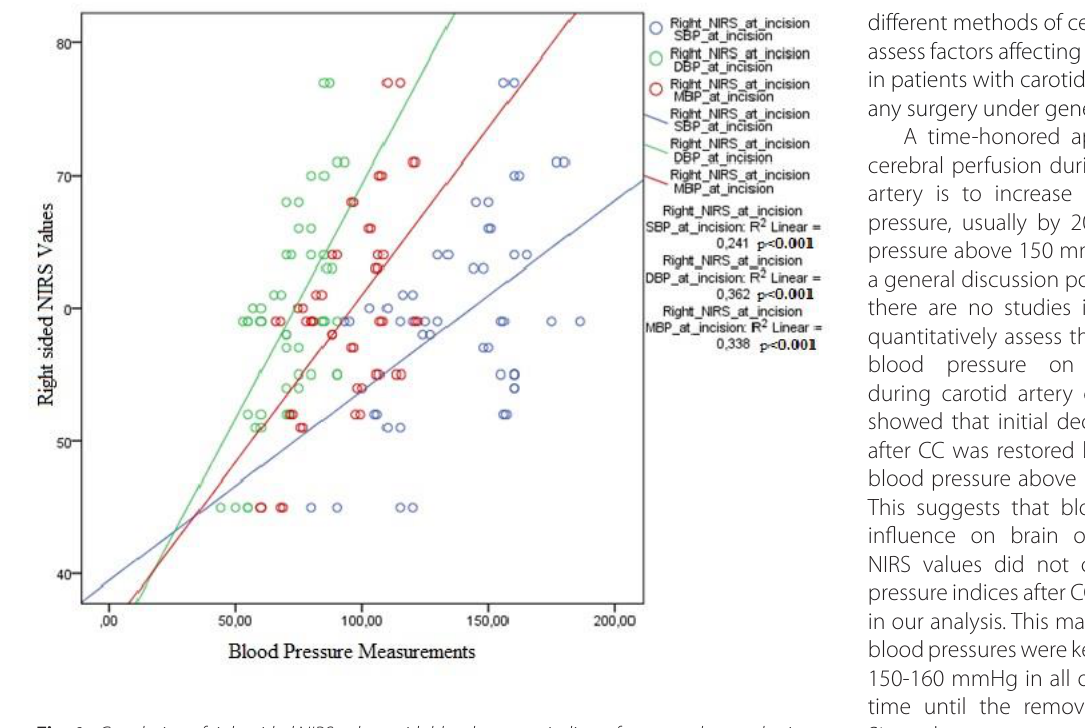
Fig. 1 - Correlation of right-sided NIRS values with blood pressure indices after general